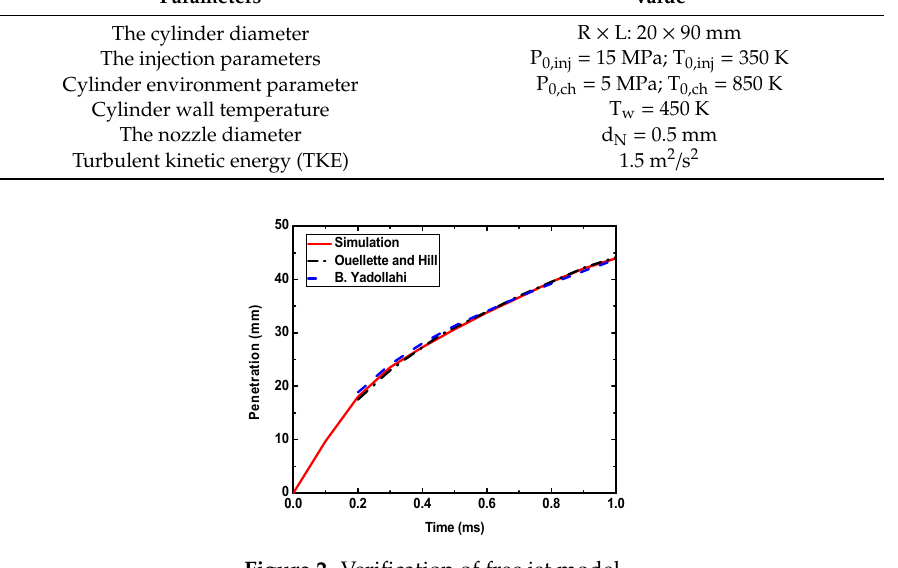
Figure 2. Verification of free jet model.